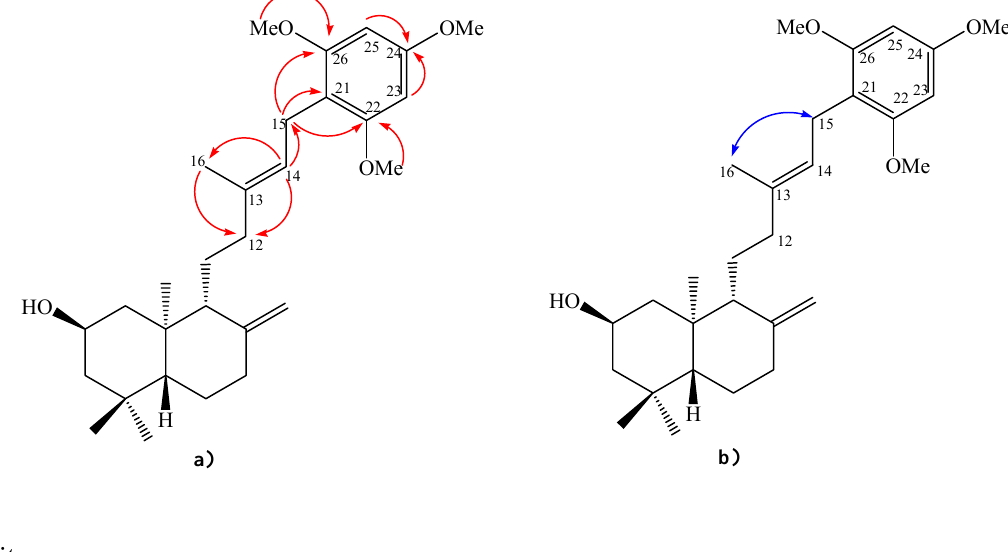
Figure 4. Structure of compound 10. ( a ) HMBC correlations; ( b ) NOE